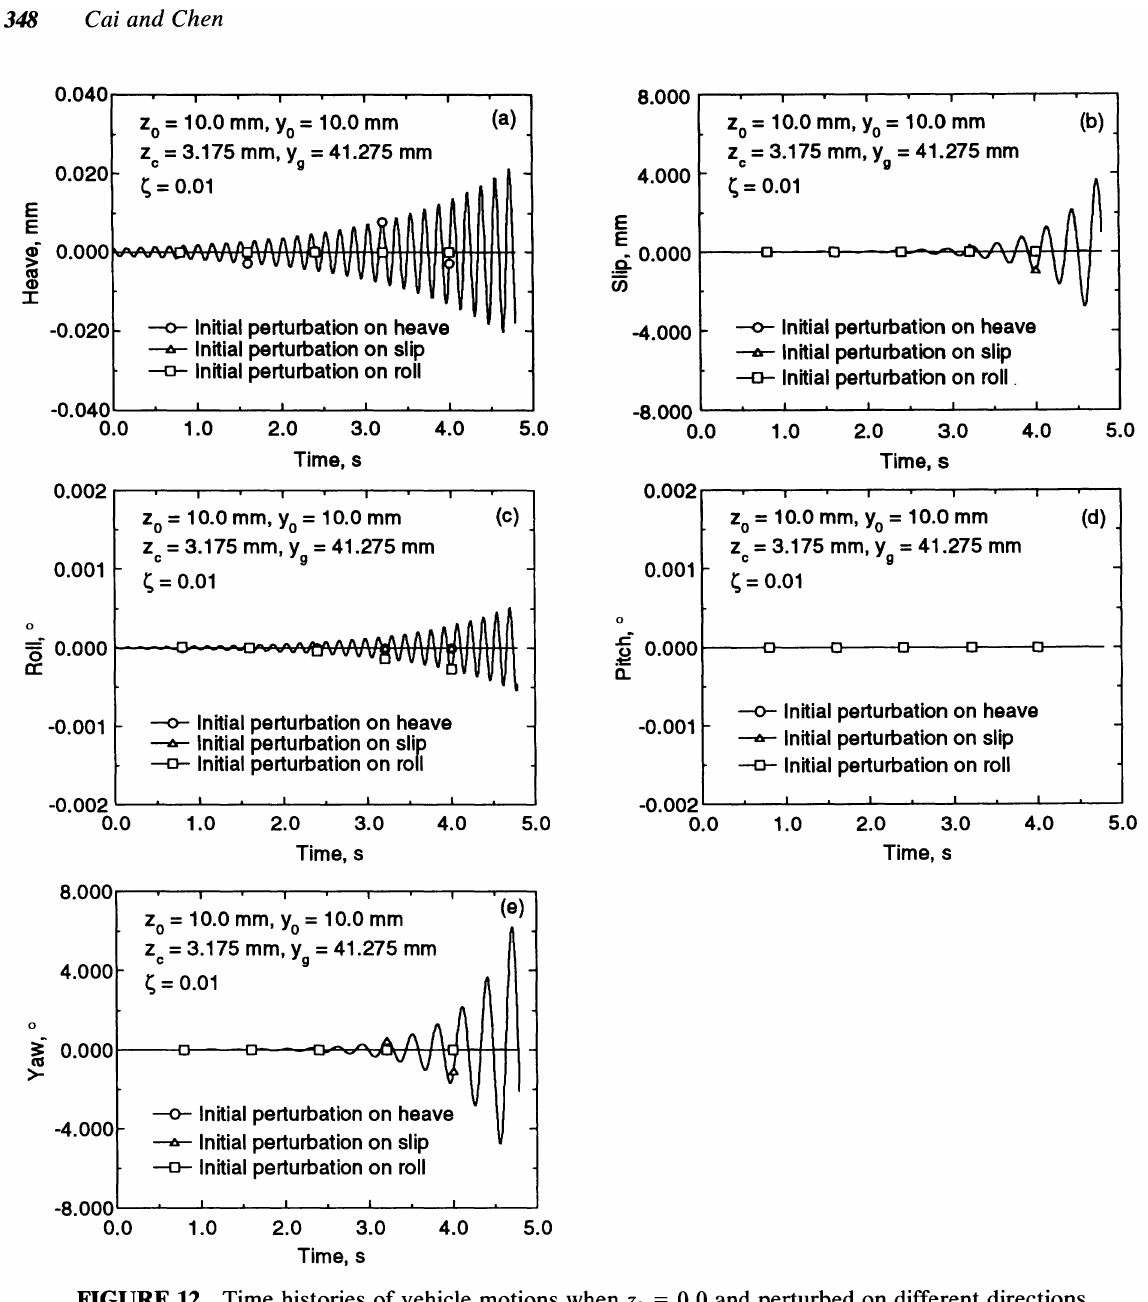
FIGURE 12 Time histories of vehicle motions when Zo = 0.0 and perturbed on different